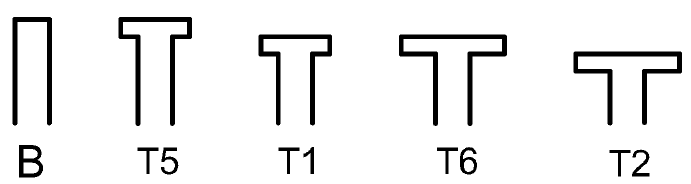
Figure 4. T5 and T6